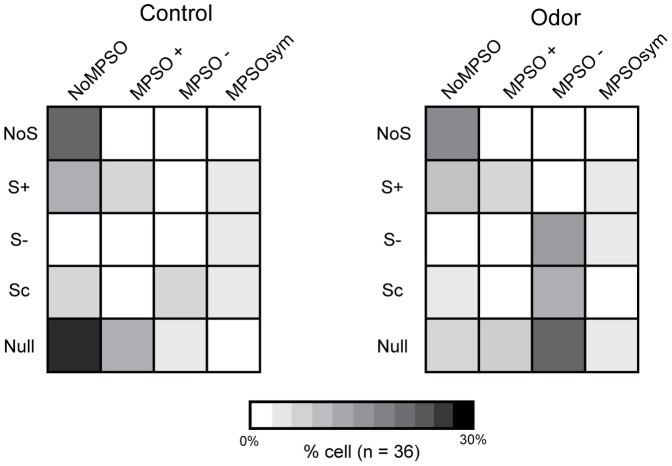
Primary study of the relationship between membrane potential slow oscillations and respiration-related discharge patterns.The percentages of cells exhibiting a specific association between different membrane potential slow oscillation types and various respiration-related discharge pattern types (n = 36) are presented for the control and odor periods. These percentages are indicated in grayscale, in which white represents a null percentage and black indicates 30% of the entire population. The 36 cells that were used to create these matrices are the same cells as those presented in Figure 2. NoMPSO: no oscillation; MPSO+: positive membrane potential slow oscillation; MPSO-: negative membrane potential slow oscillation; MPSOsym: symmetric membrane potential slow oscillation; NoS: non-synchronized pattern, S+: excitatory-simple-synchronized pattern; S-: suppressive-simple-synchronized pattern; Sc: complex synchronized pattern; Null: null activity.